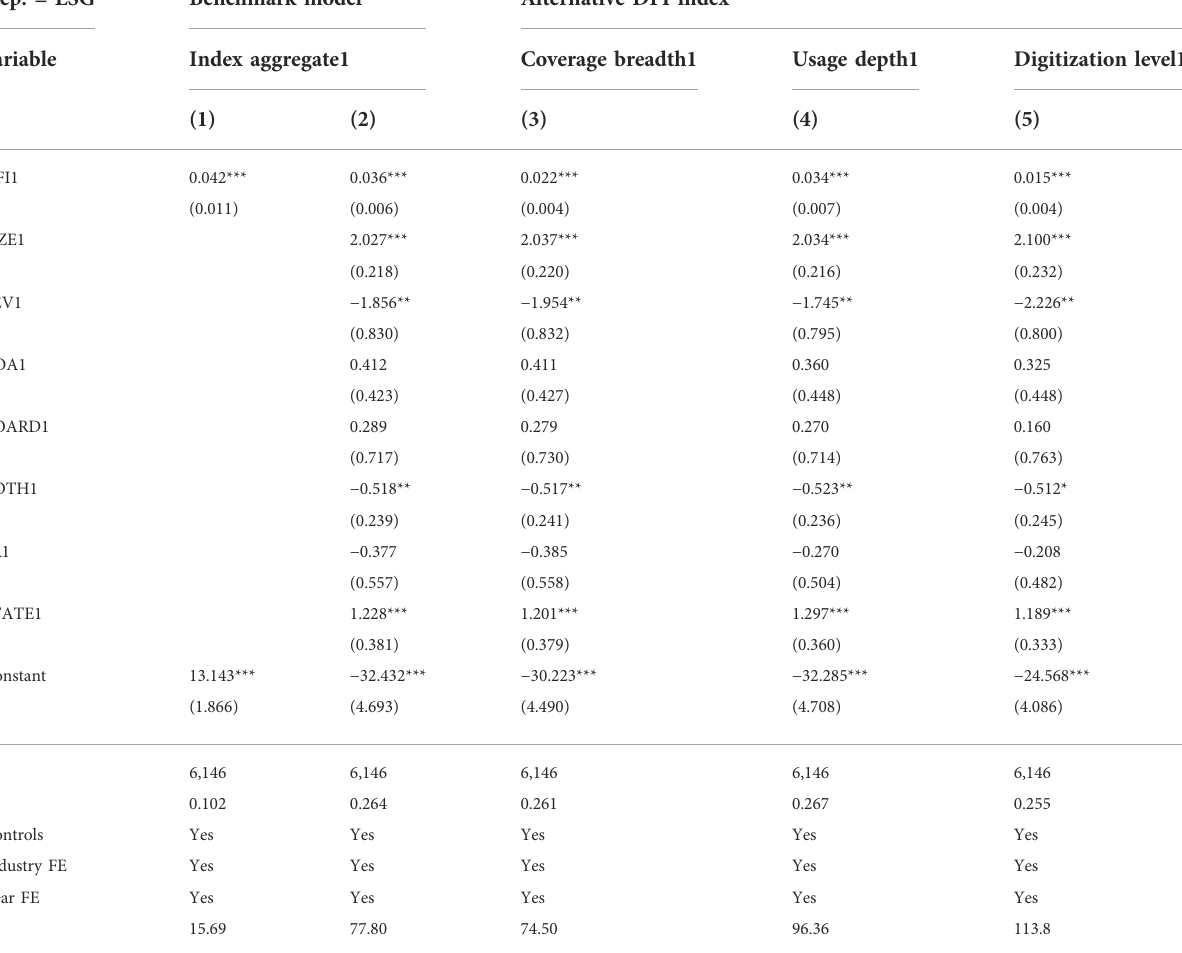
TABLE 6 Robustness